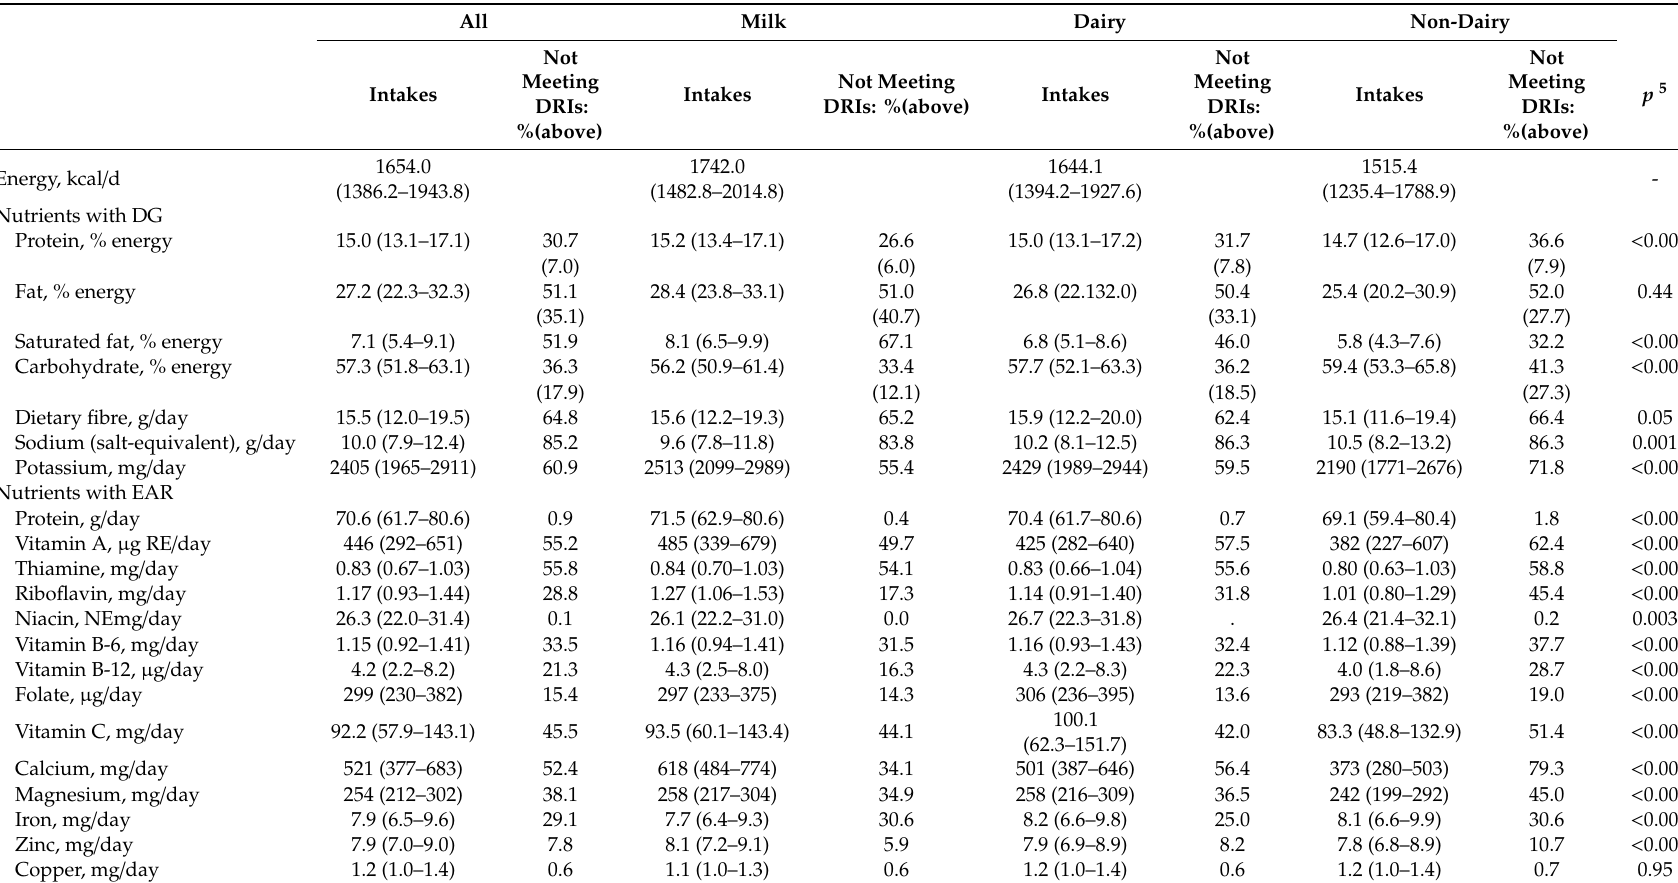
Table 5. Daily nutrient intakes and prevalence of not meeting DRIs (DG and EAR) among 11,619 women according to dairy intake status